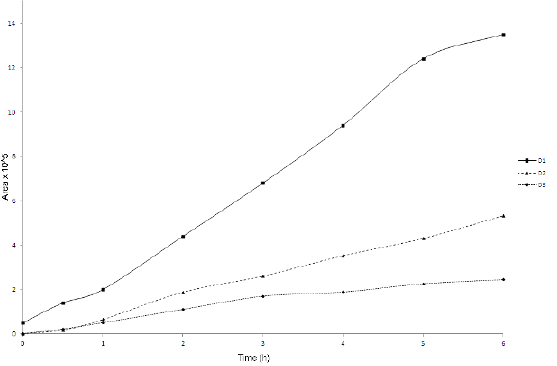
Figure 9. First-order kinetics of the photodegradation of quetiapine in methanol